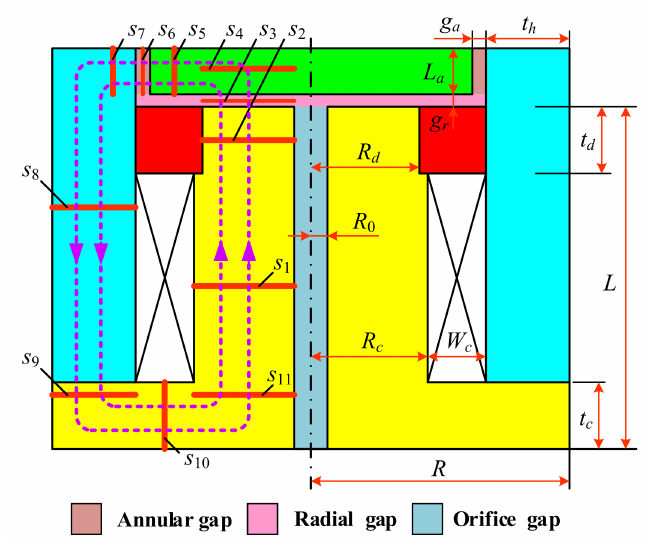
Figure 2. The simplified magnetic circuit of the annular-radial-orifice flow MR